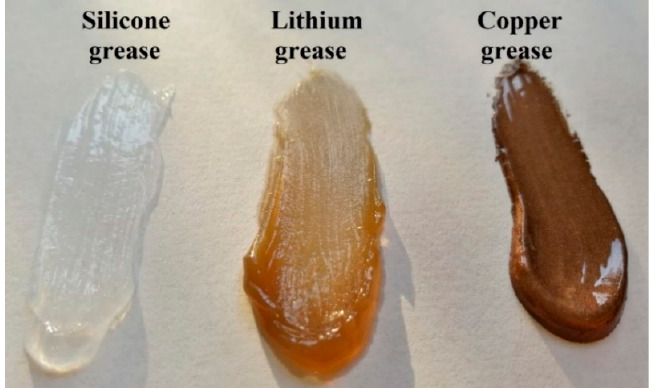
Figure 7. Visual comparison of the used lubricants.